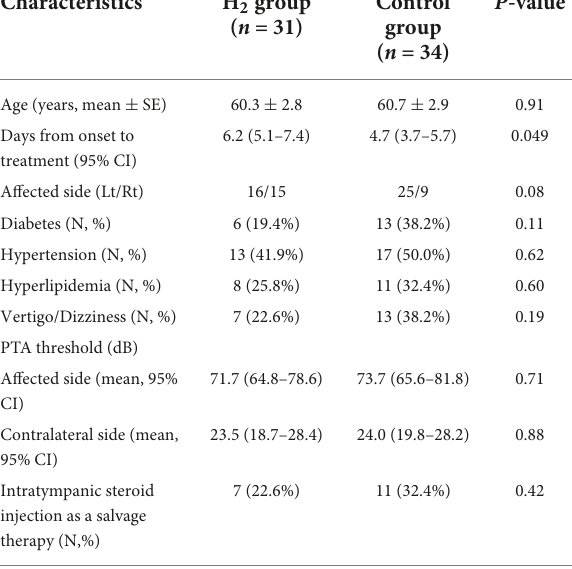
TABLE 1 Baseline patient